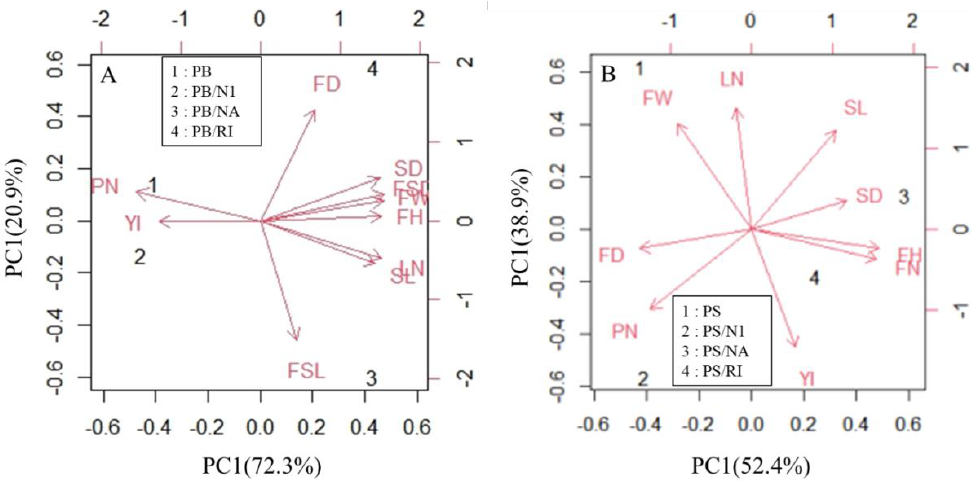
Figure 6. Biplot of the principal component analysis (PCA) of total yield and growth on grafted cut rose Rosa hybrida cv. Pink Beauty and Pink Shine between rootstock types year-round based on the data in Table 1, 2 with cutting and grafted rose being identified by numbers 1 to 4 and yield and growth parameter being identified by abbreviation. ( A ): cutting and grafted roses on rosa hybrida cv. Pink Beauty; ( B ): cutting and grafted roses on rosa hybrida cv. Pink Shine. PB: cutting on the rosa hybrida cv. Pink Beauty; PB/N1: Rosa hybrida cv. Pink Beauty grafted onto rootstock of Rosa multiflora cv. Hort No 1; PB/NA: Rosa hybrida cv. Pink Beauty grafted onto rootstock of Rosa canina cv. Natal brier; PB/RI: Rosa hybrida cv. Pink Beauty grafted onto rootstock of Rosa indica cv. Major. PS: